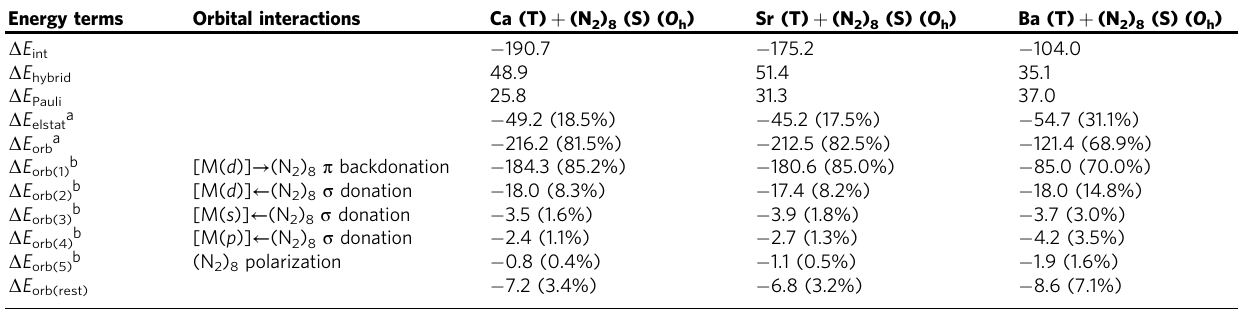
The interacting fragments are the metal atom M in the triplet excited state with a ( n )s 0 ( n − 1)d 2 valence electronic con fi guration and (N 2 ) 8 in the singlet state. Energy values are given in kcalmol − 1 a The values in parentheses give the percentage contribution to the total attractive interactions Δ E elstat + Δ E orb b The values in parentheses give the percentage contribution to the total orbital interactions Δ E orb